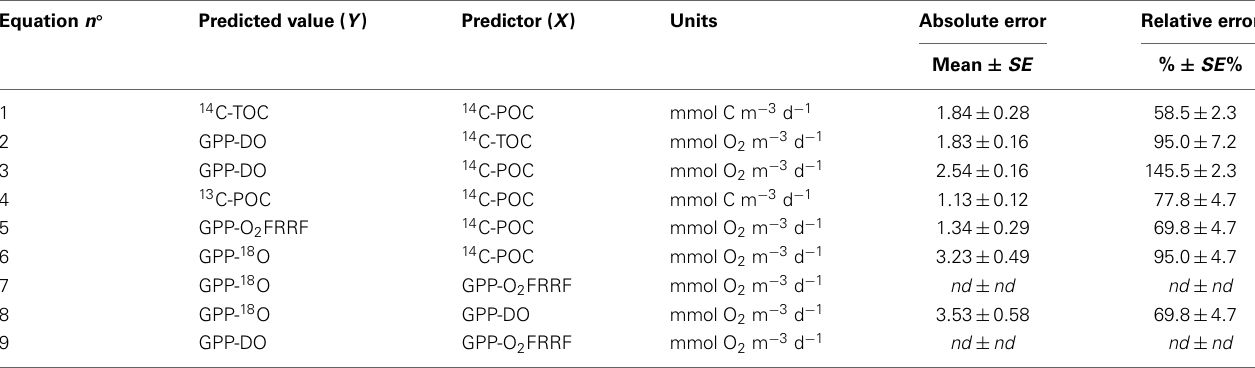
Table 5 | Error (absolute, as mean ± SE prediction error; and relative, as the mean ± SE % error) associated with the prediction of primary production in one type of method from values obtained using another